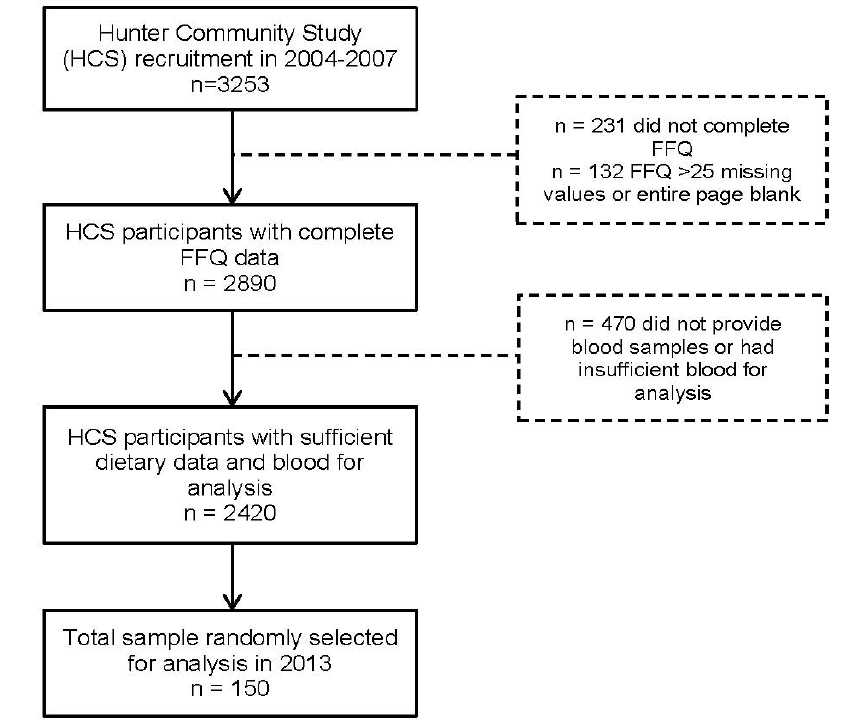
Figure 1. Participant flow diagram for a validation study of food frequency questionnaire (FFQ) estimated intakes against